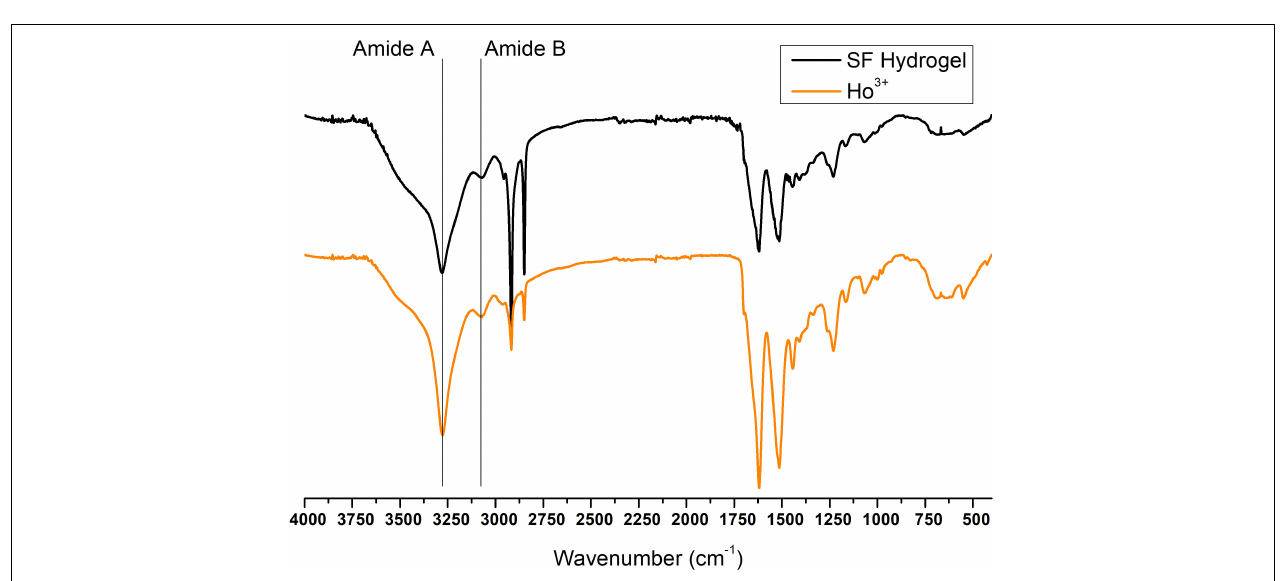
FIGURE 10 | Expansion of the amide band region, between 1,800 and 400 cm − 1 , of the ATR-FTIR spectra of degummed SF film (black curve) and films obtained by drop-casting of solutions of SF with Nd + 3 , Sm + 3 , Eu + 3 , Gd + 3 ,Tb + 3 , and Dy + 3 after purification by dialysis.